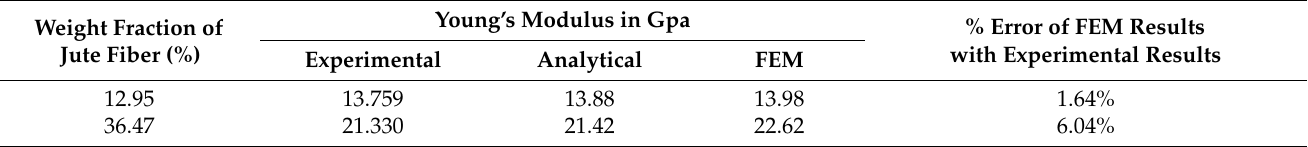
Table 5. Comparison of longitudinal modulus from experimental and simulation